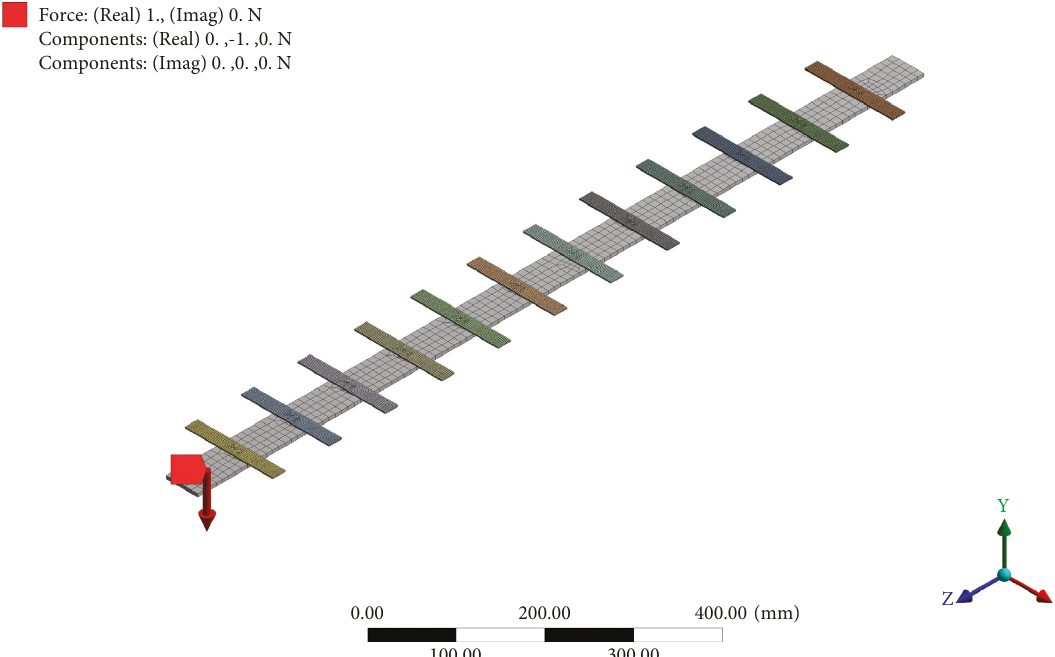
Figure 6: Structural model diagram of the finite beam with periodic arrays of